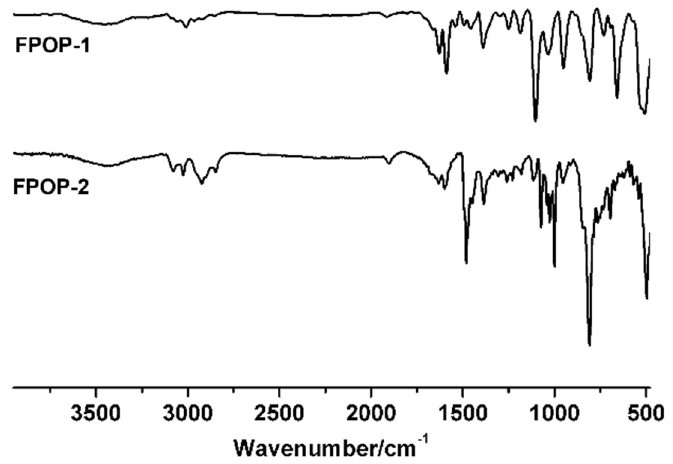
Figure 1. FT-IR of FPOP-1 and FPOP-2.